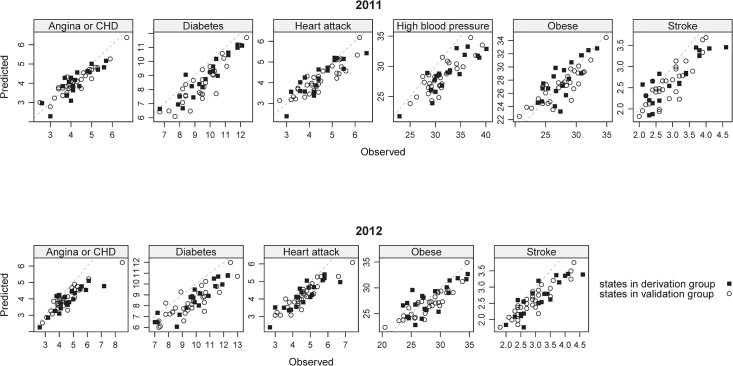
Predicted vs Observed values of state NCD and risk factor prevalence.Agreement between the predicted and the observed values is reflected by proximity of the points with the diagonal dashed lines.